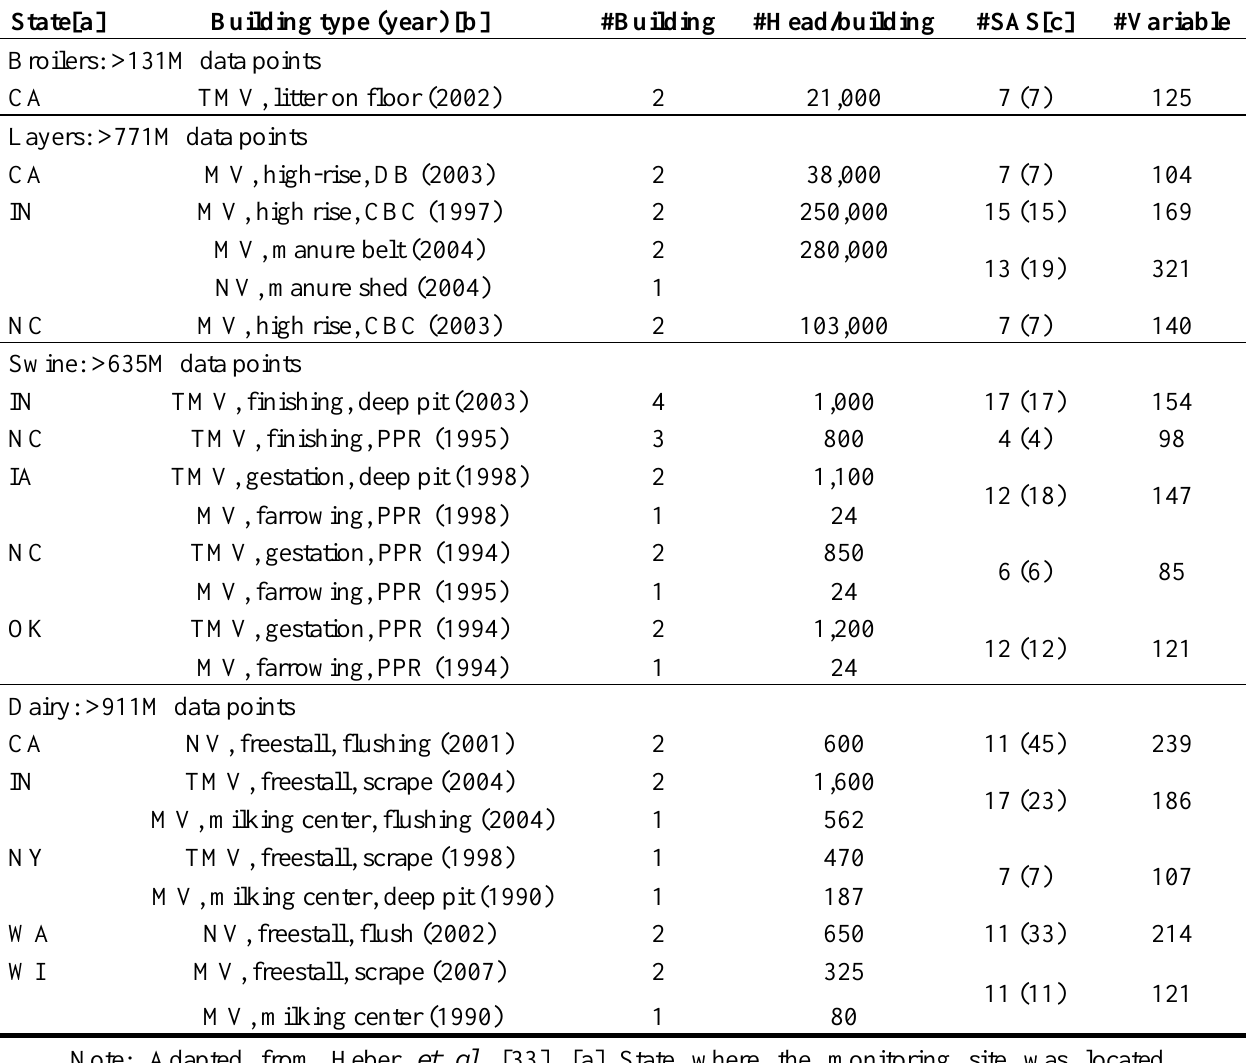
Table 2. Overview of 14 NAEMS sites in eight states in U.S. and the data